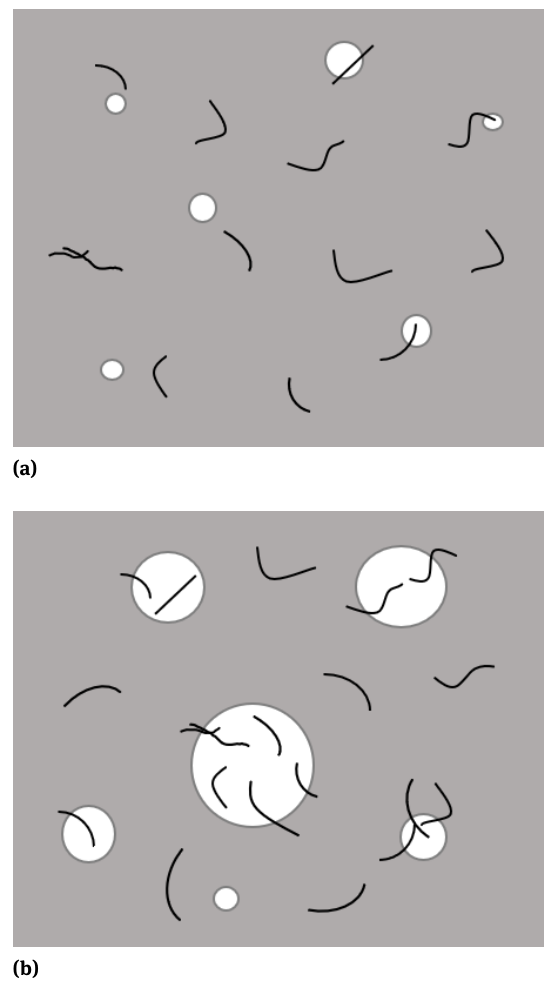
Figure 6: Flexural strength of MWCNTs reinforced UHPC after 28 days of curing